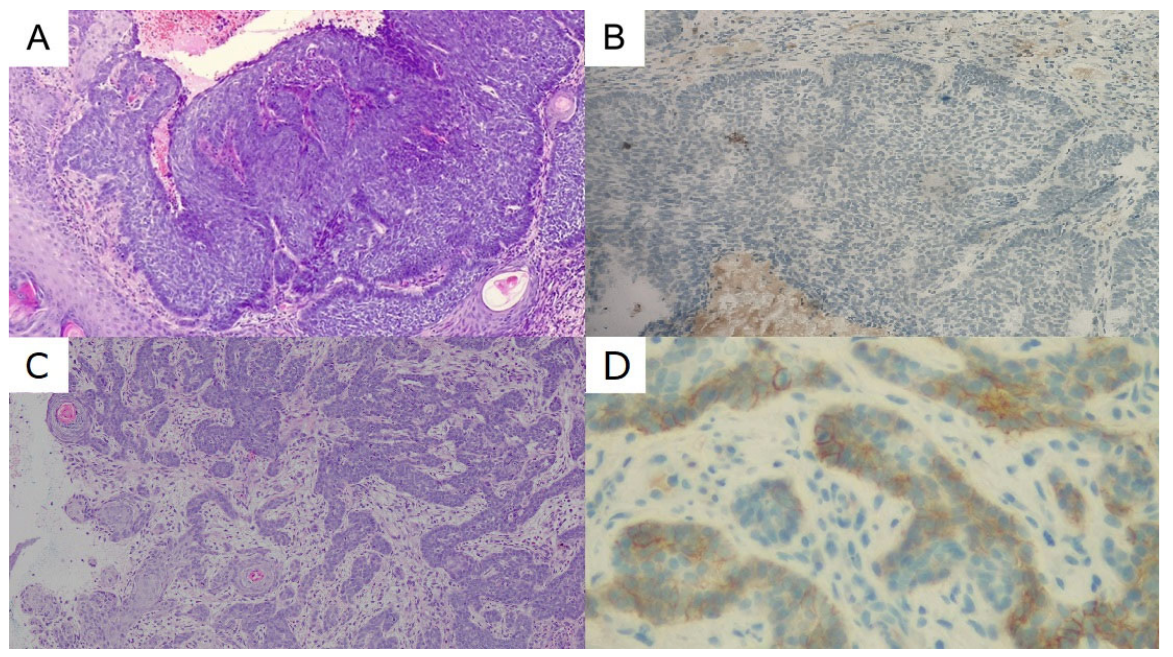
Figure 4. Histopathology of the basal cell carcinoma (BCC) in patient 2. ( A ). Routine H&E staining of the primary nodular BCC with ulceration on the face (100×). ( B ). Staining with Ber ‐ EP4 antibody showed no positive reaction from the face lesion (100×). ( C ). H&E staining of the primary skin lesion of the lumbar region with infiltrative growth pattern (100×). ( D ). Staining with BerEP4 antibody showed a membranous reaction from the tumor cells of the lumbar region (400×).